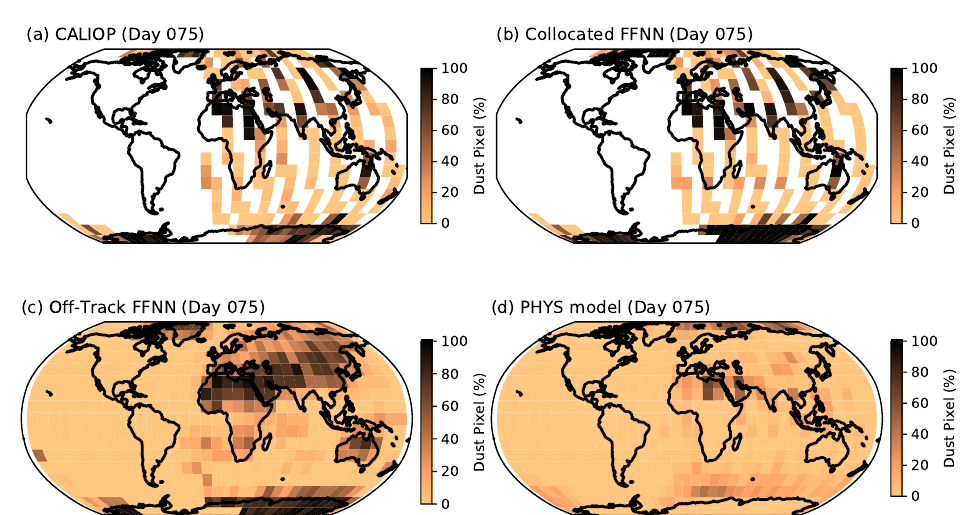
Figure 7. Dust distribution of day 075 for ( a ) on-track CALIOP product, ( b ) on-track FFNN prediction, ( c ) off-track FFNN, and ( d ) off-track PHYS. Missing observations where there are no CALIOP overpass are marked as white.